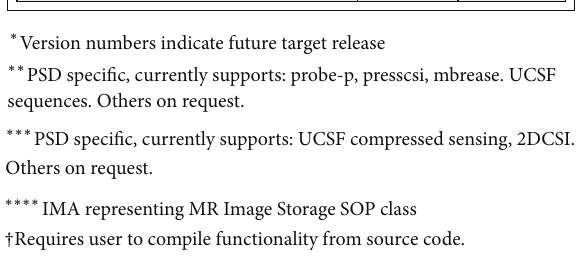
Figure 3: File formats supported by the svk IO layer are shown. SIVIC provides support for parsing raw data formats such as the GE P-file and Varian FID files, though interpreting the data may be sequence specific requiring customization to svk reader software classes. Version numbers indicate target SIVIC release to provide